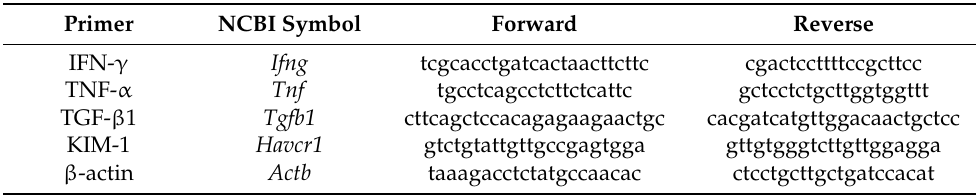
Table 2. Real-time RT–PCR